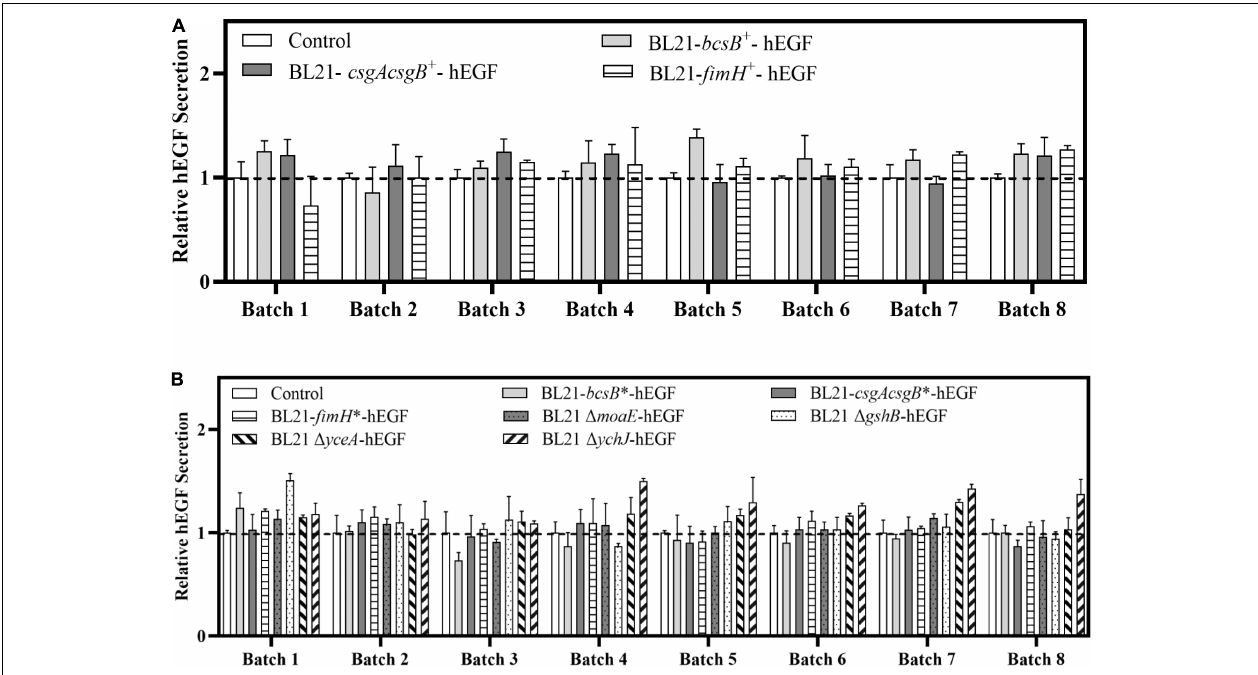
FIGURE 6 | Effects of different gene manipulations on hEGF secretion in biofilm-based fermentation (repeated batch fermentation) in LB medium. (A) Relative hEGF secretion of strains with plasmid-based expression of biofilm related genes. (B) Relative hEGF secretion of strains with genome-integrated expression of or disruption of biofilm related